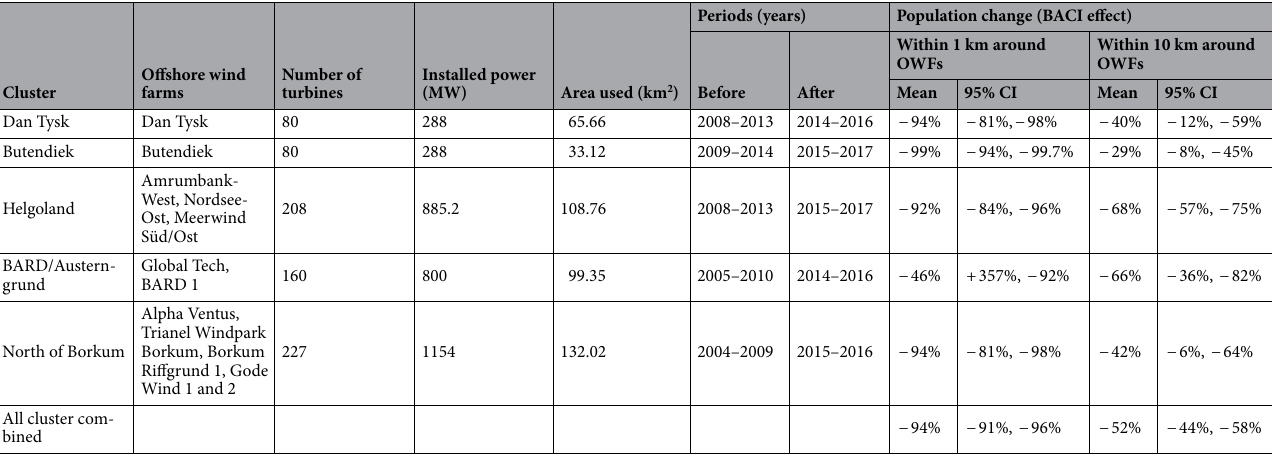
Table 1. Definition of wind farm clusters, years of data analysis, and changes in loon populations determined by BACI analysis. BACI before-after control-impact, CI confidence interval.